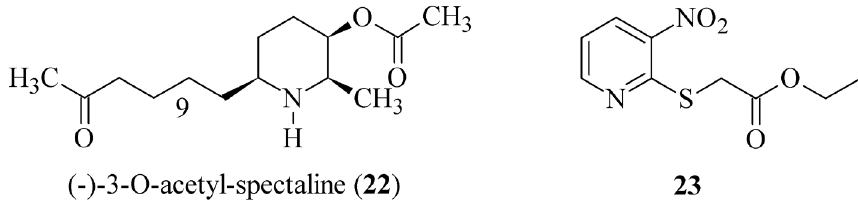
Figure 8 - the natural alkaloid (–)-3- O -acetylspectaline ( 22 ) isolated from S. spectabilis and its derivative ( 23 ).